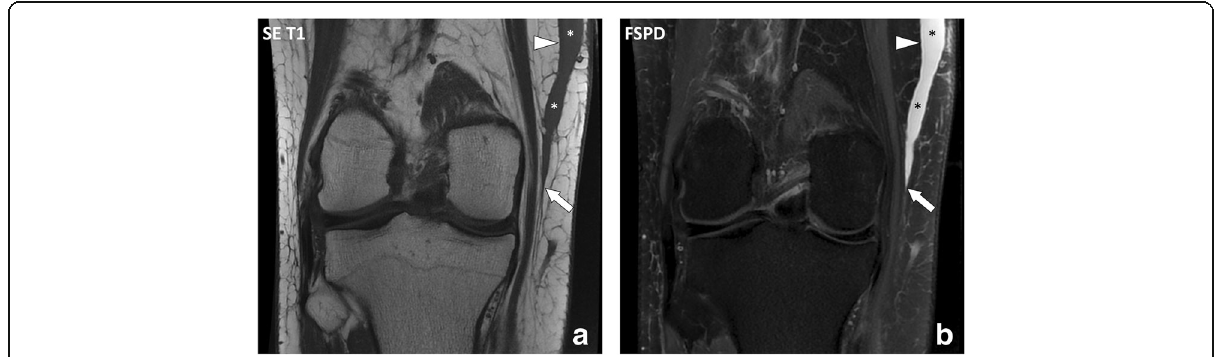
Fig. 3 Coronal ( a ) SE T1w and ( b ) fat-suppressed proton density-weighted (FSPD) images of the right knee of a 23-year-old male with Morel-Lavallée lesion after a motorcycle accident. MRI demonstrates a fluid collection (asterisks) extending from the interface between the hypodermis and deep peripheral fascia (arrow) along the fascia superficialis (arrowhead)